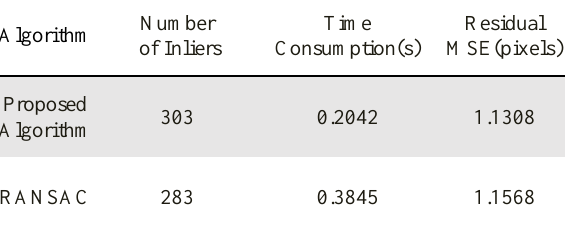
(a) Initial matching point connection diagram